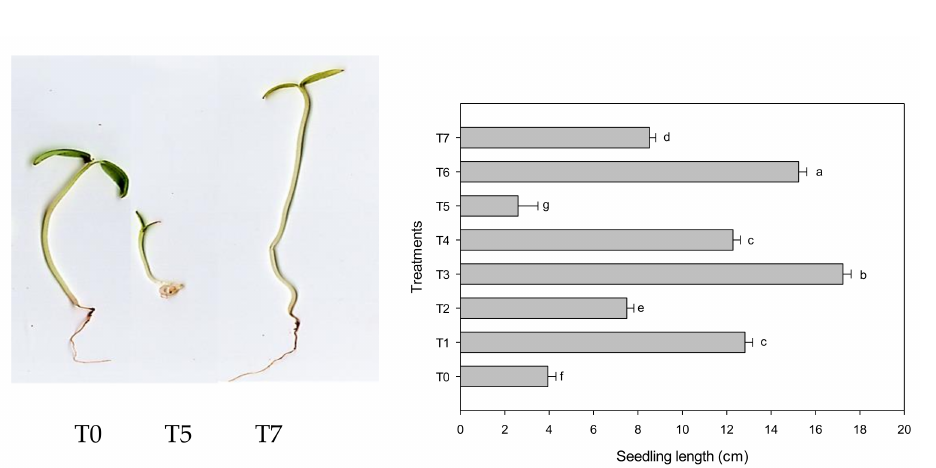
Figure 2. Effect of SWE on mitigating seedling length of salt-strained tomato seeds. Mean ( ± SEM) of 5 replicates. Within each time point, the same letter indicates no significant difference ( p ≤ 0.05) in a